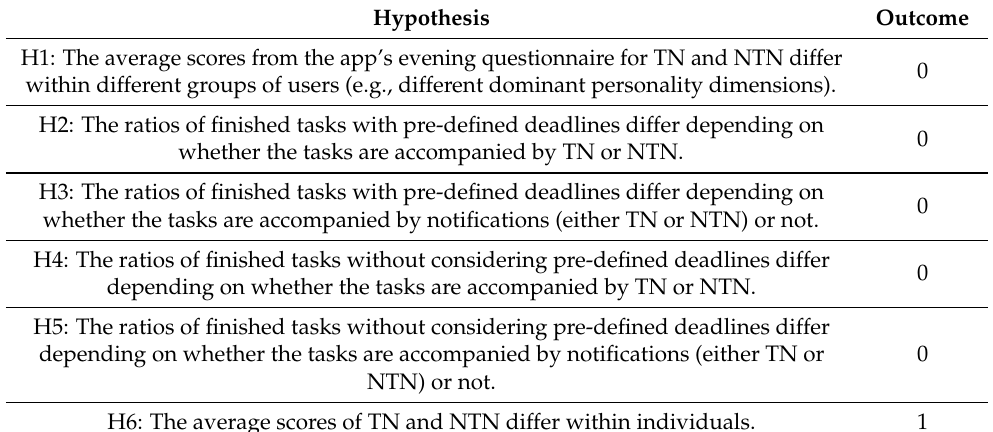
Table 1. Table with listed hypotheses and outcome (1—Confirmed; 0—Rejected) from our analysis. Hypothesis Outcome